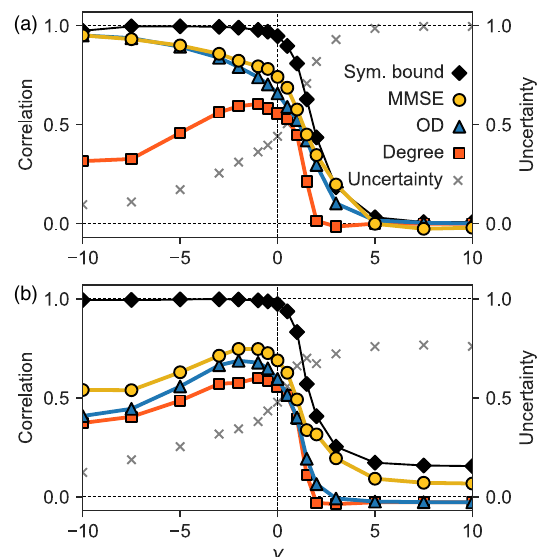
FIG. 3. Effect of the rich-get-richer phenomenon on recovery. We analyze artificial networks of T ¼ 50 edges, generated with our generalization of the preferential attachment and the param- eters γ ∈ ½ − 10 ; 10 (cid:2) , (a) b ¼ 1 (trees), and (b) b ¼ 0 . 75 (loopy networks). We plot the average correlation attained by the Monte Carlo approximation of the minimum mean-squared error (MMSE) estimators and two efficient methods based on network properties (a degree-based method and the onion decomposition [58]). A loose upper bound that accounts for network symmetry is also shown [see Eq. (17)] as well as a measure of our uncertainty of the MMSE estimators (right axis) [see Eq. (8)]. Each point is obtained by averaging the results over m different network instances, where ( b ¼ 1 ) m ¼ 40 and ( b ¼ 0 . 75 ) m ¼ 250 . We use the true parameters ( γ , b ) and n Monte Carlo samples to approximate the MMSE estimators, where n ¼ 10 5 ( b ¼ 1 ) and n ¼ 5 × 10 6 ( b ¼ 0 . 75